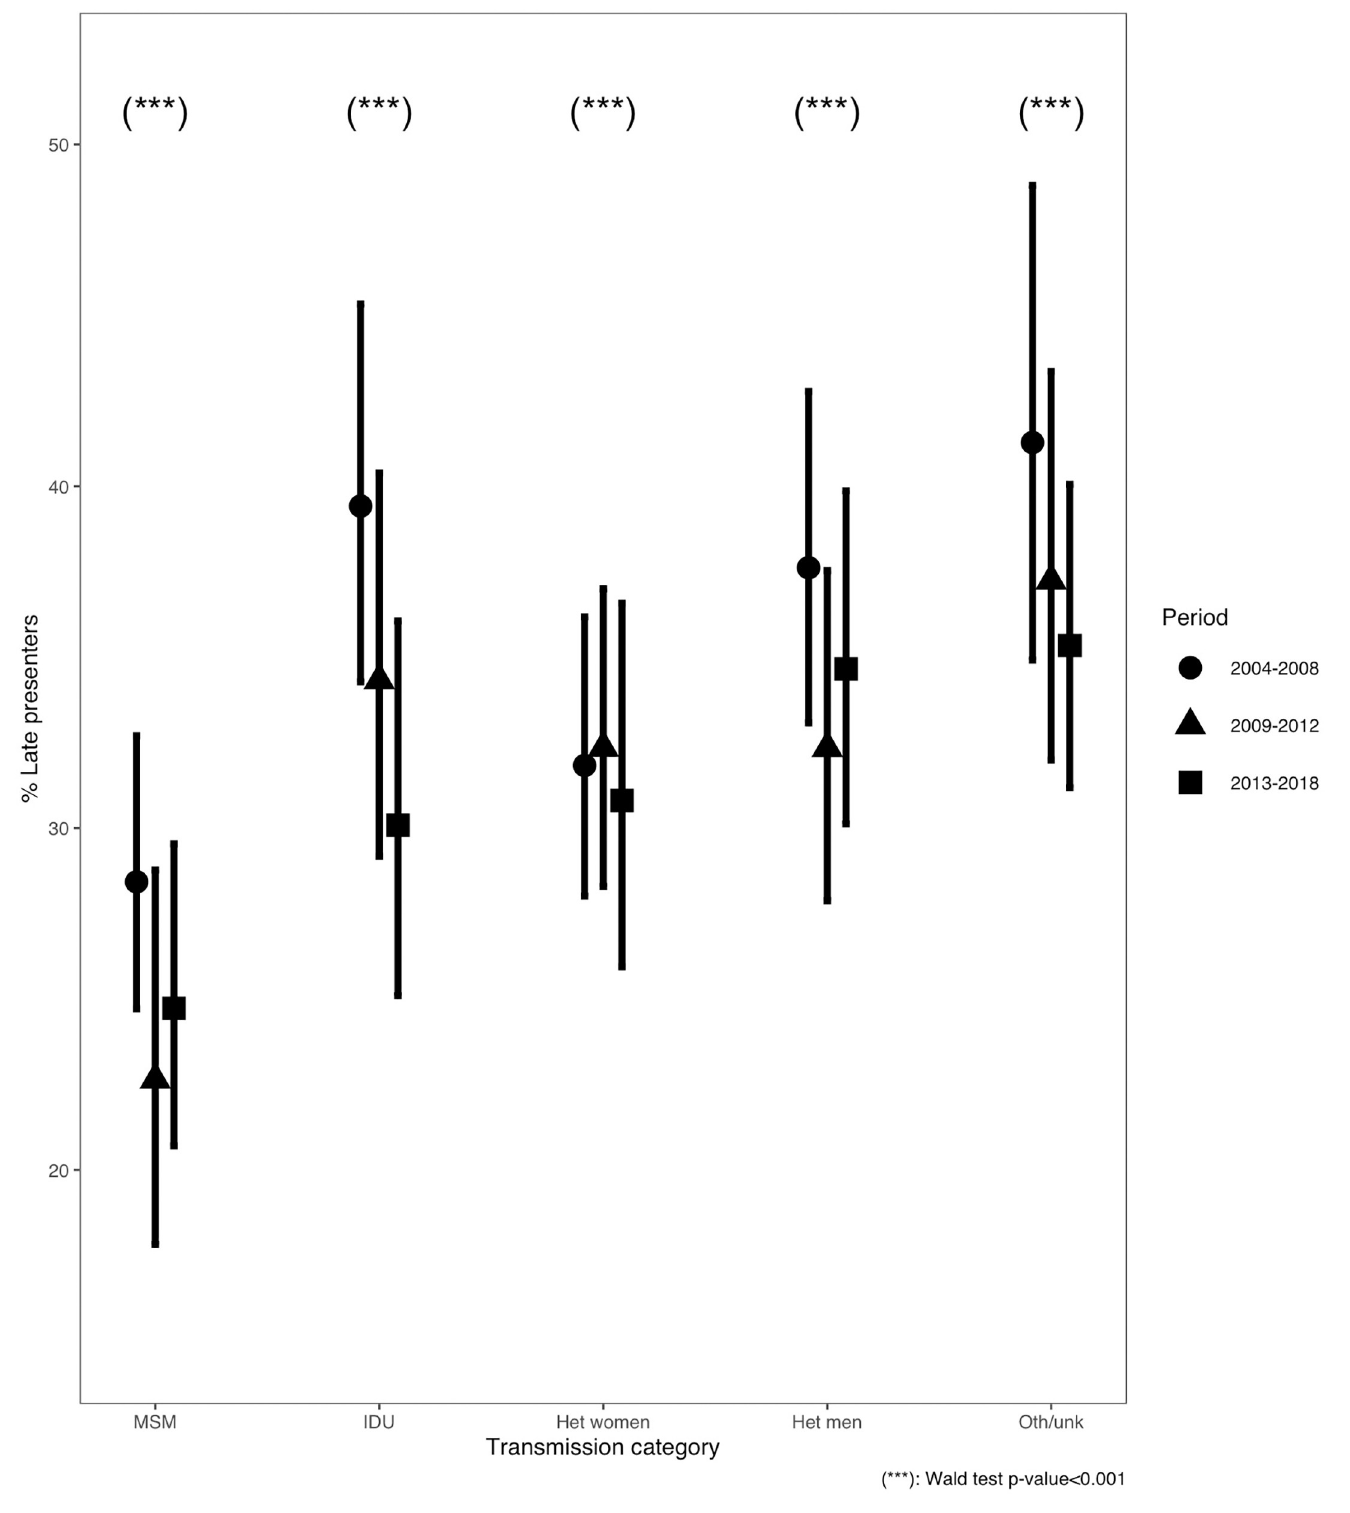
Fig 2. Adjusted prevalence of late presentation by transmission category and time-period.